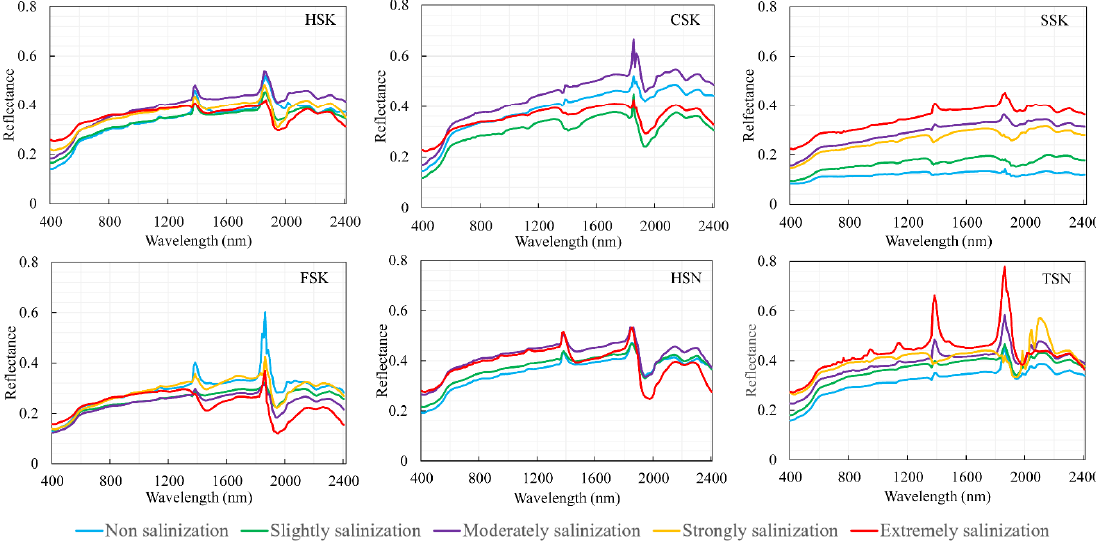
Figure 4. Spectral reflectance of the hyperspectral data depending on different salinization degree.